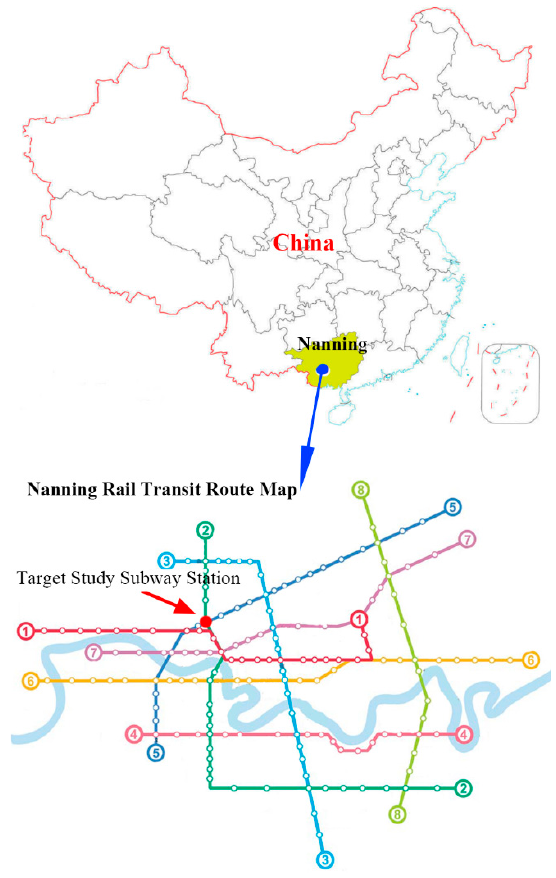
Figure 2. Location of the target study station.